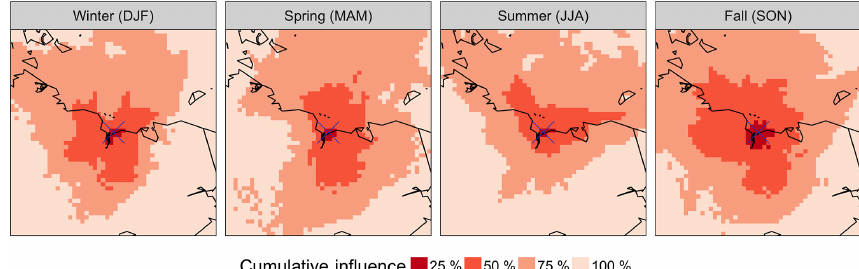
Figure 7. Cumulative Ambarchik footprints based on 15d back trajectories for August 2014–December 2015. The footprints were aggregated over the winter (December–January–February), spring (March–April–May), summer (June–July–August), and fall (September–October– November) seasons, and sorted into bins covering 25% of the cumulative influence each. Shown here is a zoom in of the center of the 3200km × 3200km domain on which the footprints were computed, covering 1600km ×